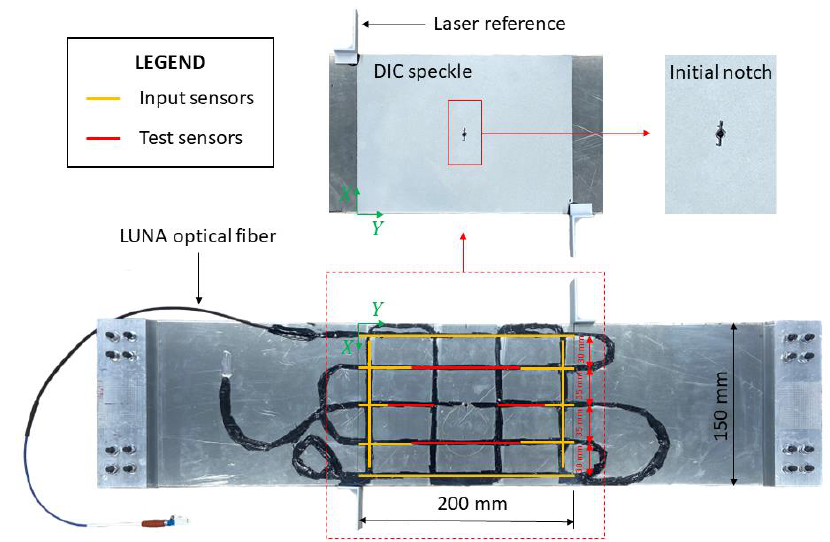
Figure 8. Specimen with the sensor